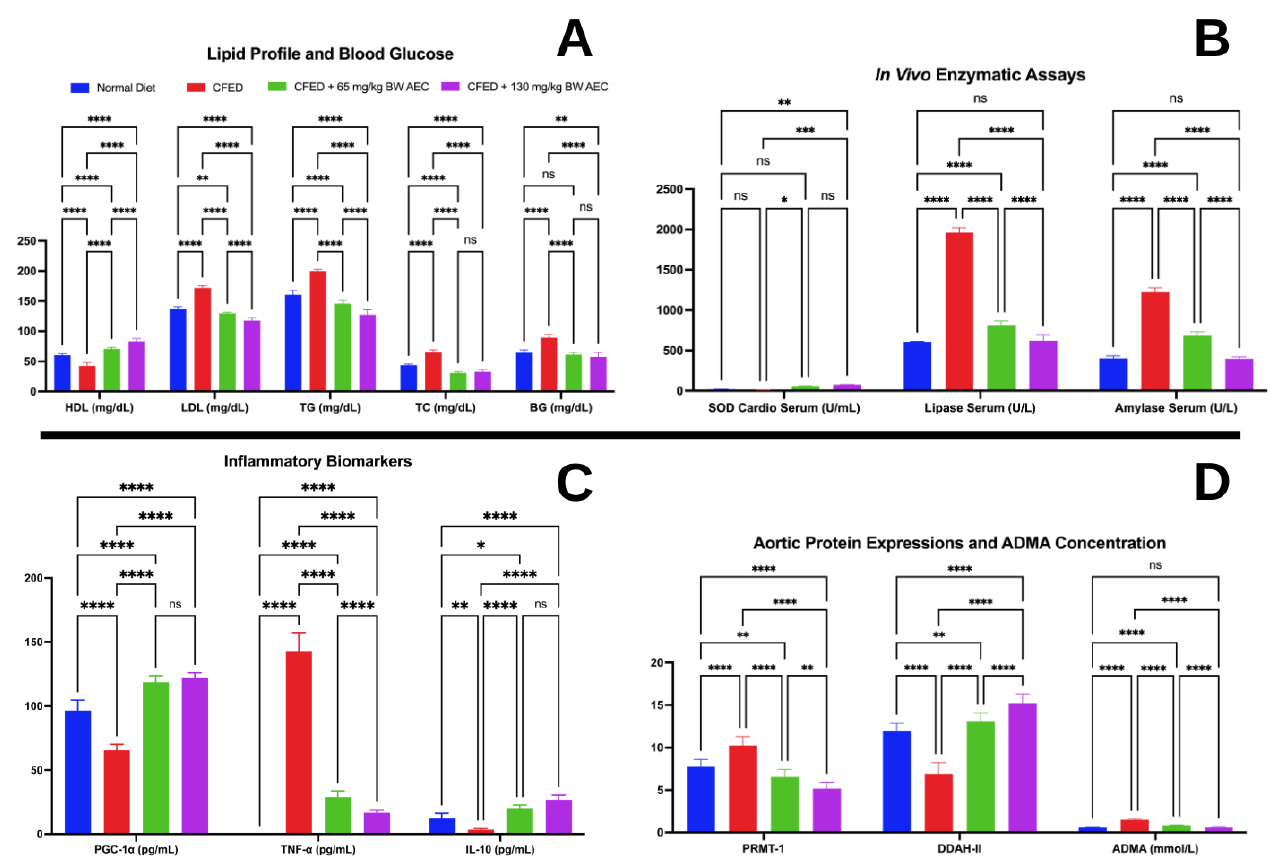
Figure 2. Effect of the aqueous extract of Caulerpa racemosa (AEC) on cardiometabolic markers. ( A ) Improvement of blood lipid and glucose profile of CFED mice by AEC. ( B ) Significance of improvements in SOD in cardio serum, lipase, and amylase in serum. ( C ) Improvement of inflammatory markers in CFED mice by dietary AEC. ( D ) Amelioration of cardiometabolic syndrome via regulation of PRMT-1/DDAH/ADMA pathway. ns: p = 0.1638 ( p > 0.05); * : p = 0.0125; ** : p = 0.0067; *** : p = 0.0007; **** : p < 0.0001. HDL = high-density lipoprotein; LDL = low-density lipoprotein; TG = triglycerides; TC = total cholesterol; BG = blood glucose; PGC-1 α = peroxisome proliferator-activated receptor-gamma coactivator (PGC)-1alpha; TNF- α = tumor necrosis factor -alpha; IL-10 = interleukin 10; PRMT-1 = protein arginine N-methyltransferase 1; DDAH-II = dimethylarginine dimethylaminohydrolase 2; ADMA = plasma asymmetric dimethylarginine; CFED: cholesterol- and fat-enriched diet.